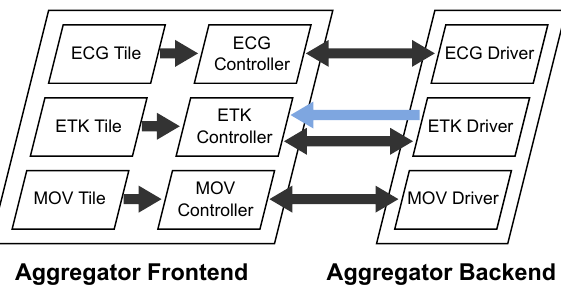
Figure 6. Frontend-to-Backend communication within the Aggregator